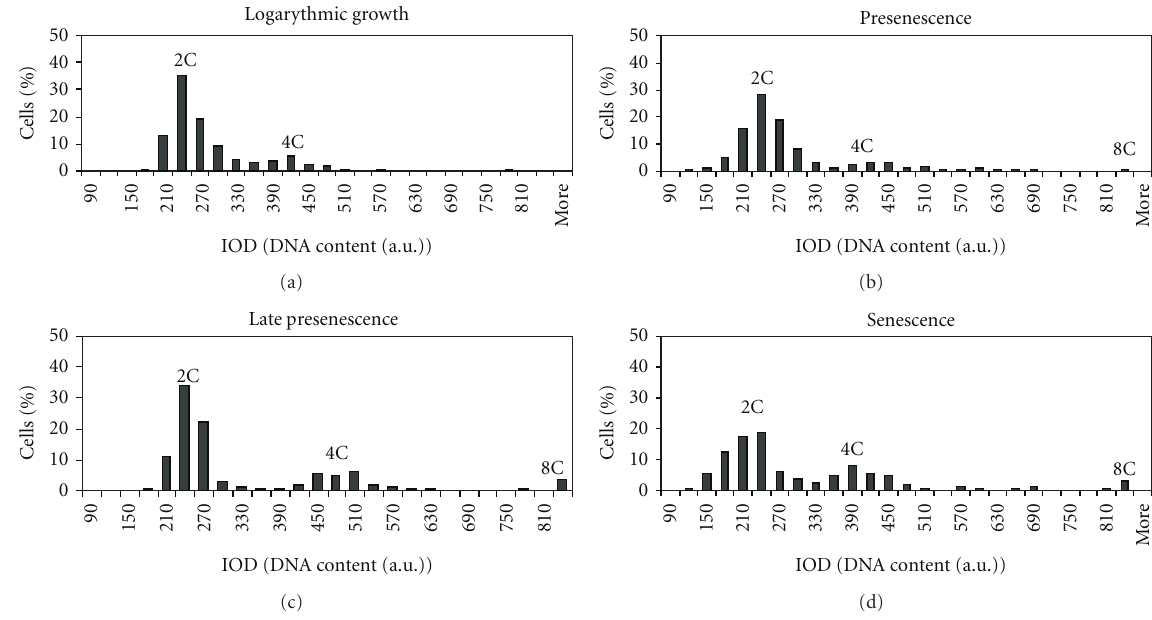
Figure 2: Histograms of IMR90 DNA content in several passages showing typical changes in the time course: (a) logarithmic growth, (b) presenescence, (c) late presenescence, and (d) senescence showing the accumulation of 4C cells and the increase of the proportion of hypertetraploid cells, some of which reach octoploidy.